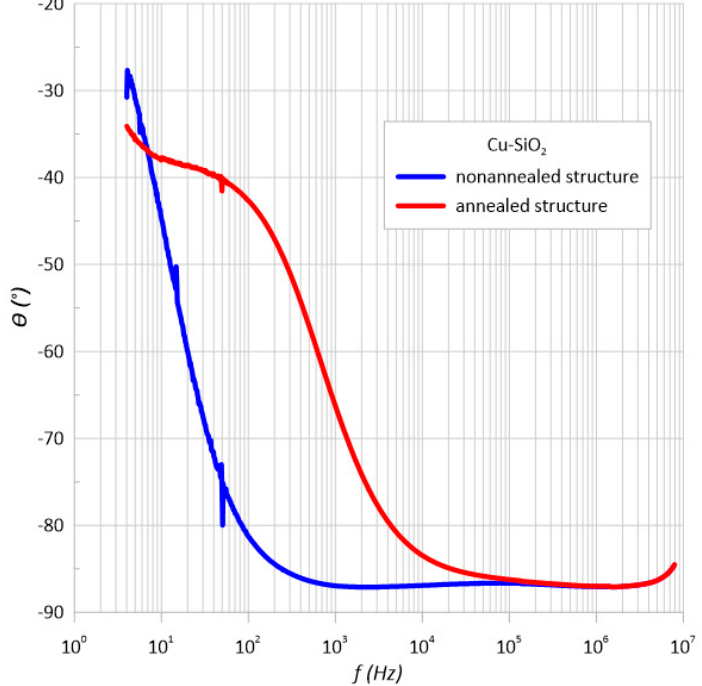
Figure 6. Frequency relationship of the phase shift angle θ measured at room temperature immedi- ately after the preparation process and after heating at T a = 473 K.